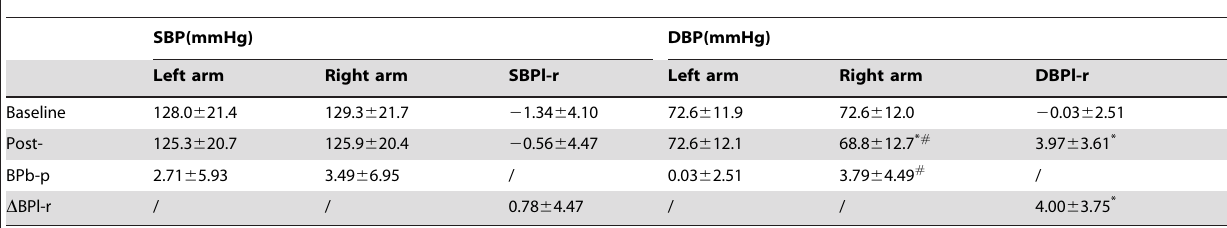
D BPl-r / / 0.78 6 4.47 / / 4.00 6 3.75 * *compared with baseline p , 0.05; # compared with left arm. Post-: after right arm ischemia; BPb-p: same-arm BP differences before and after ischemia; D BPl-r: BPl-r change following ischemia; (BPl-r: BP difference between left and right arms).